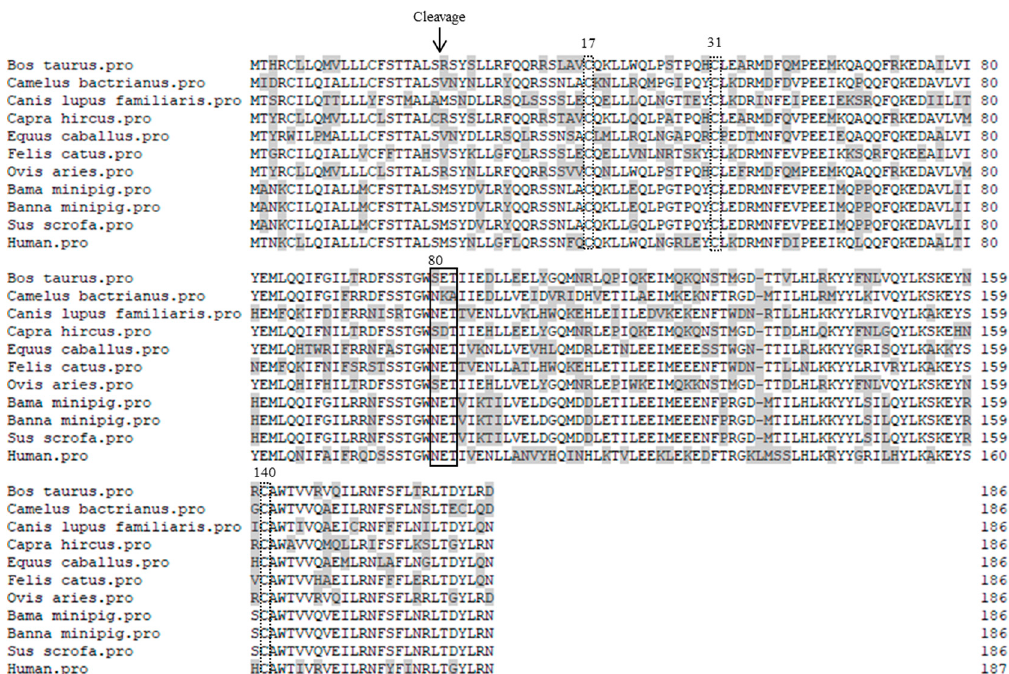
Figure 2. Amino acid sequence alignment of IFN ‐β proteins between different animal species. The cleavage site of signal peptides is indicated with an arrow. Amino acid substitutions are shadowed. The conserved cysteine residues at the indicated positions are dot line ‐ boxed. Putative N ‐ glycosyl ‐ ation sites are solid line ‐ boxed.